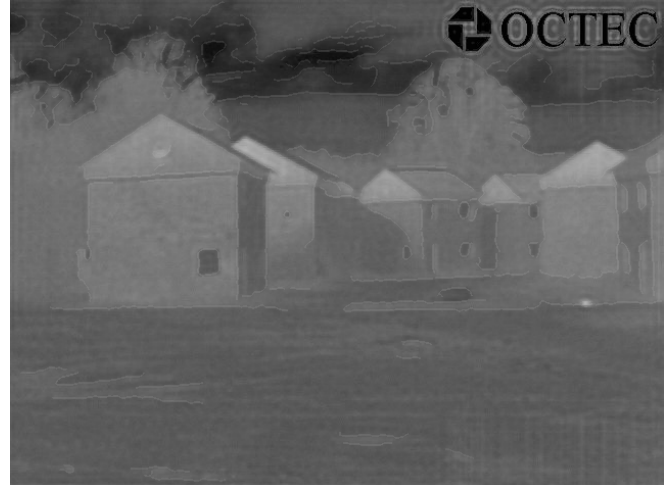
Figure 7. Blended result of IR Image 2 when only original IR image is